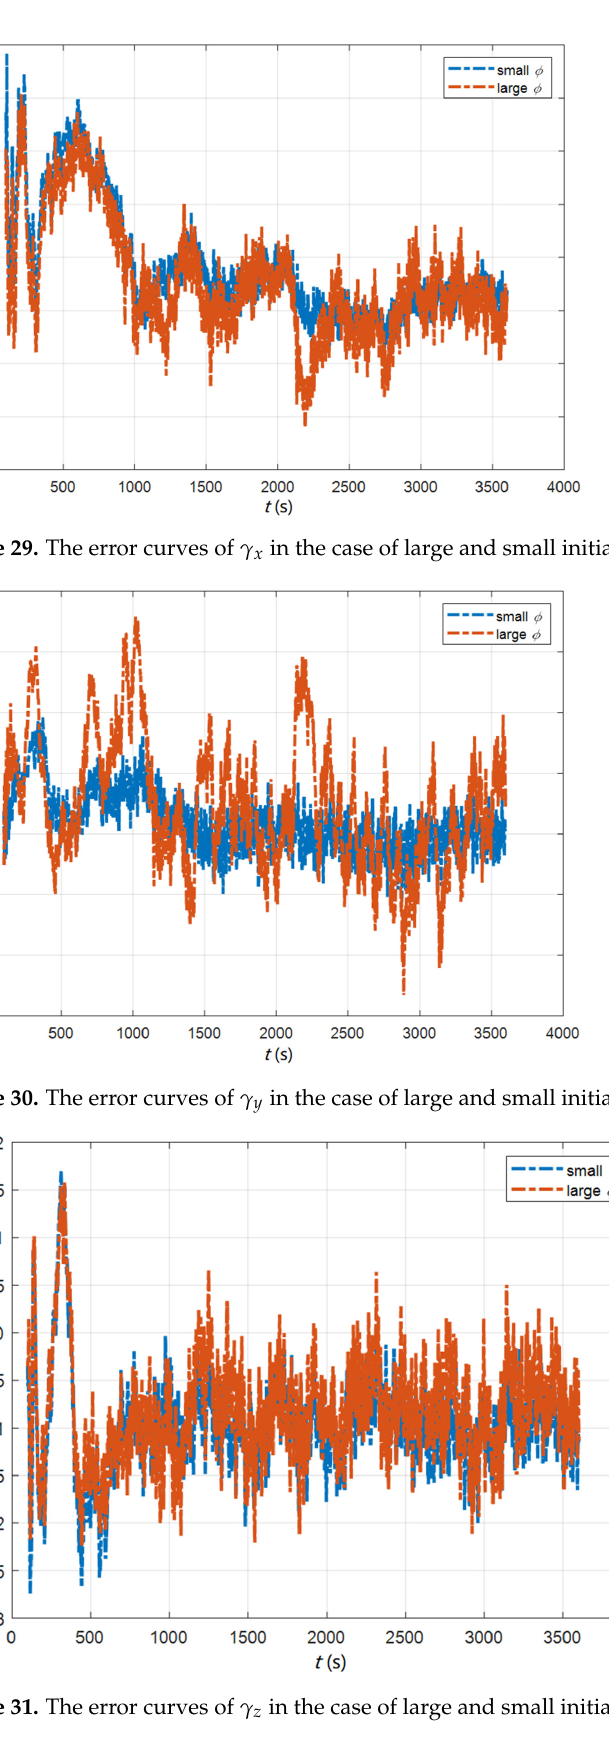
γ Figure 31. The error curves of z in the case of large and small initial misalignment angles. Figure 31. The error curves of γ z in the case of large and small initial misalignment